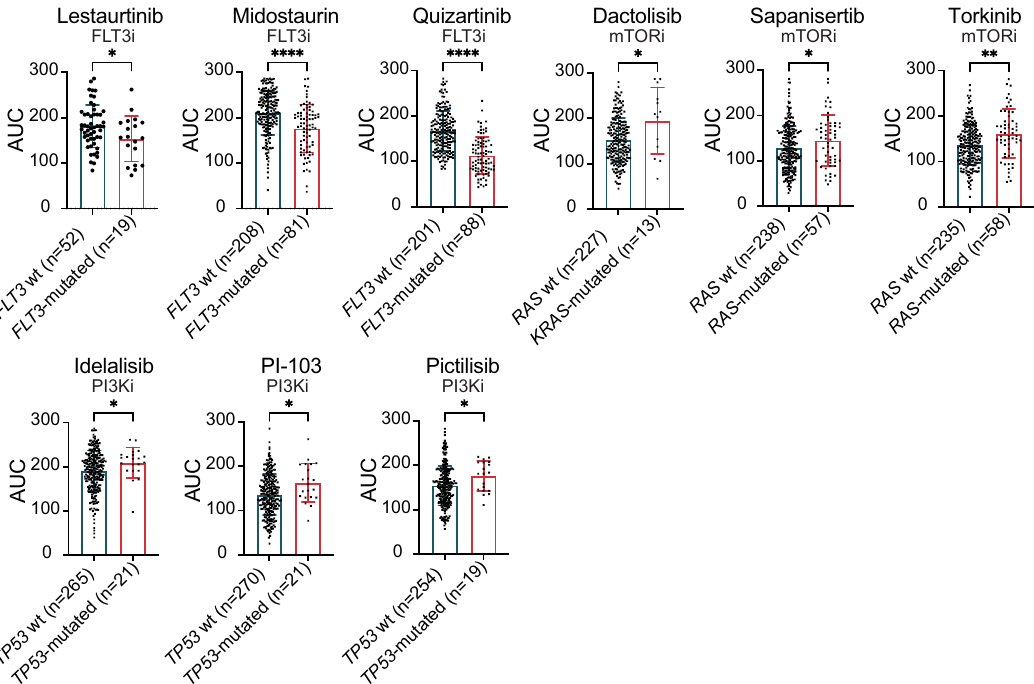
Fig. 3 Metabolic coregulation revealed by genotype to phenotype associations. a Summary of the most recurrent mutational events as well as FAB subtype annotation of the cell line panel included in the study. b Bubble plot describing the signi fi cant genotype to phenotype associations discerned with a two-sided equal variance t -test between mutant and wild-type cases. The size of each bubble corresponds to adjusted P value signi fi cance level with FDR of 10% (* P adj ≤ 0.1; ** P adj < 0.05; *** P adj < 0.01). c Validation of selected phenotype to genotype associations (where data available) from the Beat AML study 33 (data retrieved from http://www.vizome.org/aml/). Box plots showing sensitivity of several metabolic modi fi ers that have signi fi cantly higher or lower sensitivity in FLT3 , RAS , and TP53 mutant vs. wild-type AML patient samples. The number of independent samples for each comparison is indicated in the fi gure. Higher values, here, indicate lack of sensitivity and lower values indicate sensitivity. Error bars signify mean ± SD and the difference in response was assessed with either a two-tailed unpaired t -test or Mann – Whitney test (* P ≤ 0.05; ** P ≤ 0.01; *** P ≤ 0.001; **** P ≤